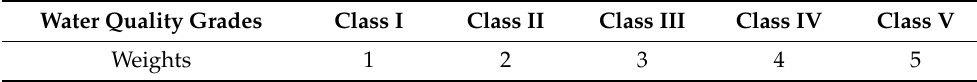
Table 6. Weightings of different water grade